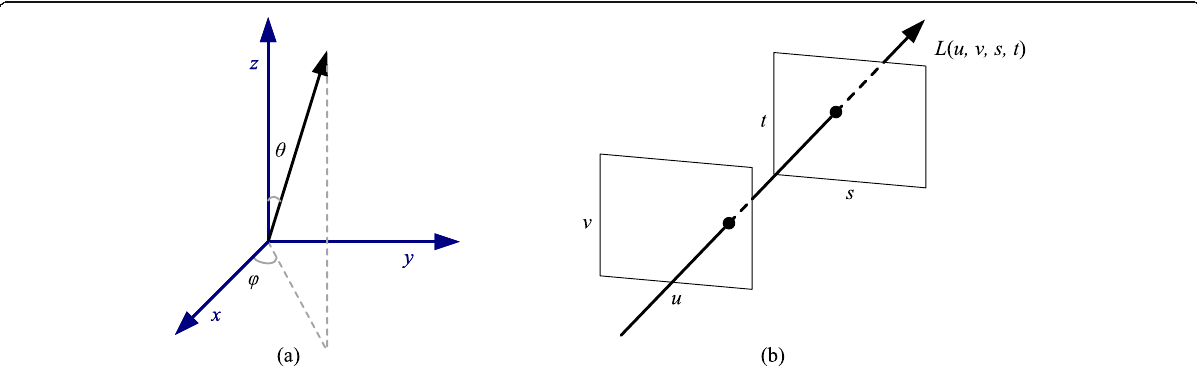
Fig. 1 5D and 4D light field representations. a L ( x , y , z , θ , φ ) ∈ R 5 , where ( x, y, z ) represents the coordinates, and ( θ , φ ) represents the angles between the light ray and the planes; b L ( u , v , s , t ) ∈ R 4 , where ( u, v ) represents the first plane and ( s, t ) the second plane